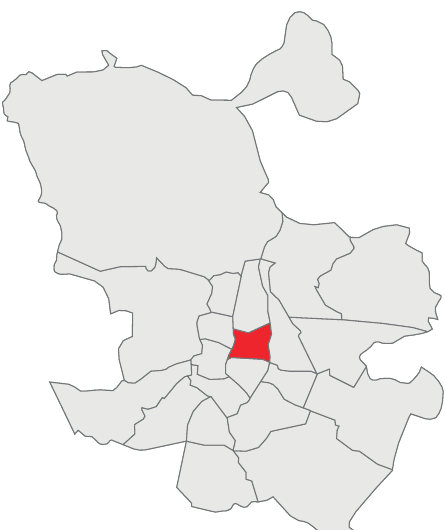
Figure 3. Location of the Salamanca district within the city of